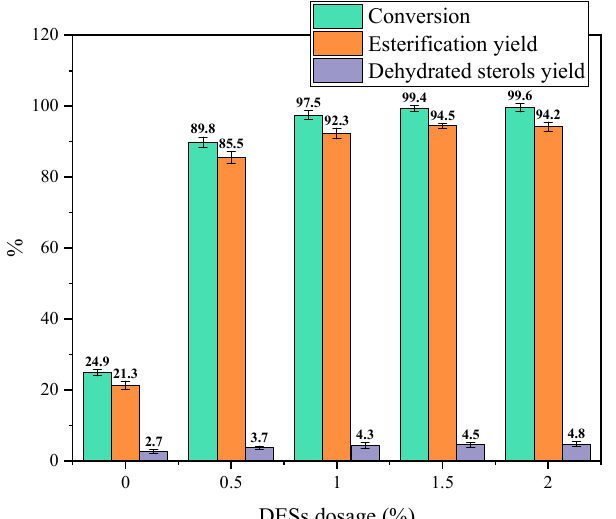
Figure 3. Effect of DESs dosage. Reaction conditions: 2 mmol pine sterols, 3 mmol oleic acid, 120 °C, 5 h.